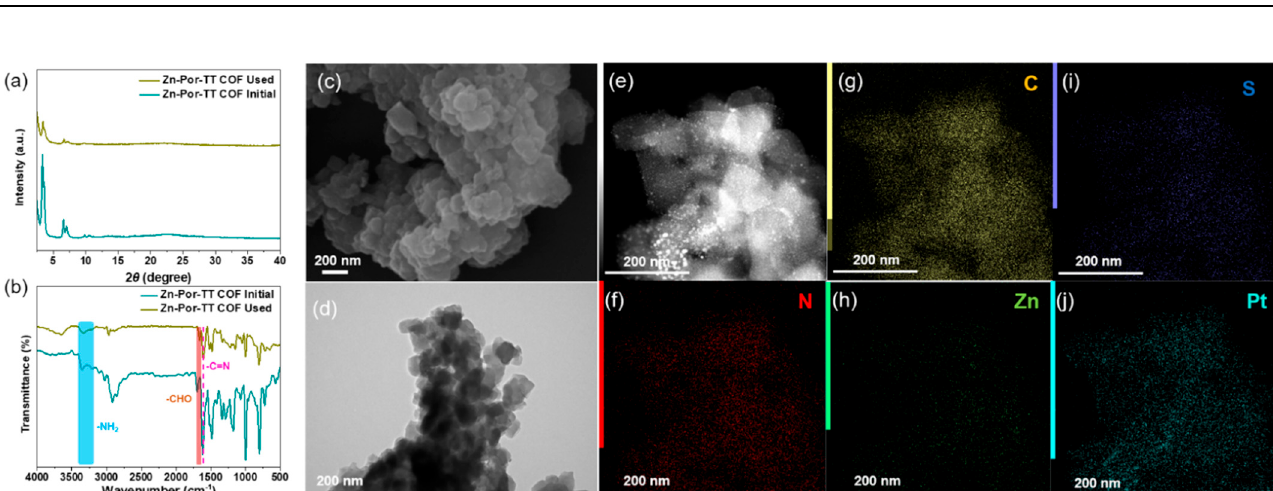
Figure 7. ( a ) PXRD pattern of Zn-Por-TT COF before and after photocatalysis; ( b ) FT-IR spectra of Zn-Por-TT COF before and after photocatalysis; ( c ) SEM of Zn-Por-TT COF after photocatalysis; ( d ) TEM of Zn-Por-TT COF after photocatalysis; and ( e – j ) EDS Maps of Zn-Por-TT COF after photocatalysis.